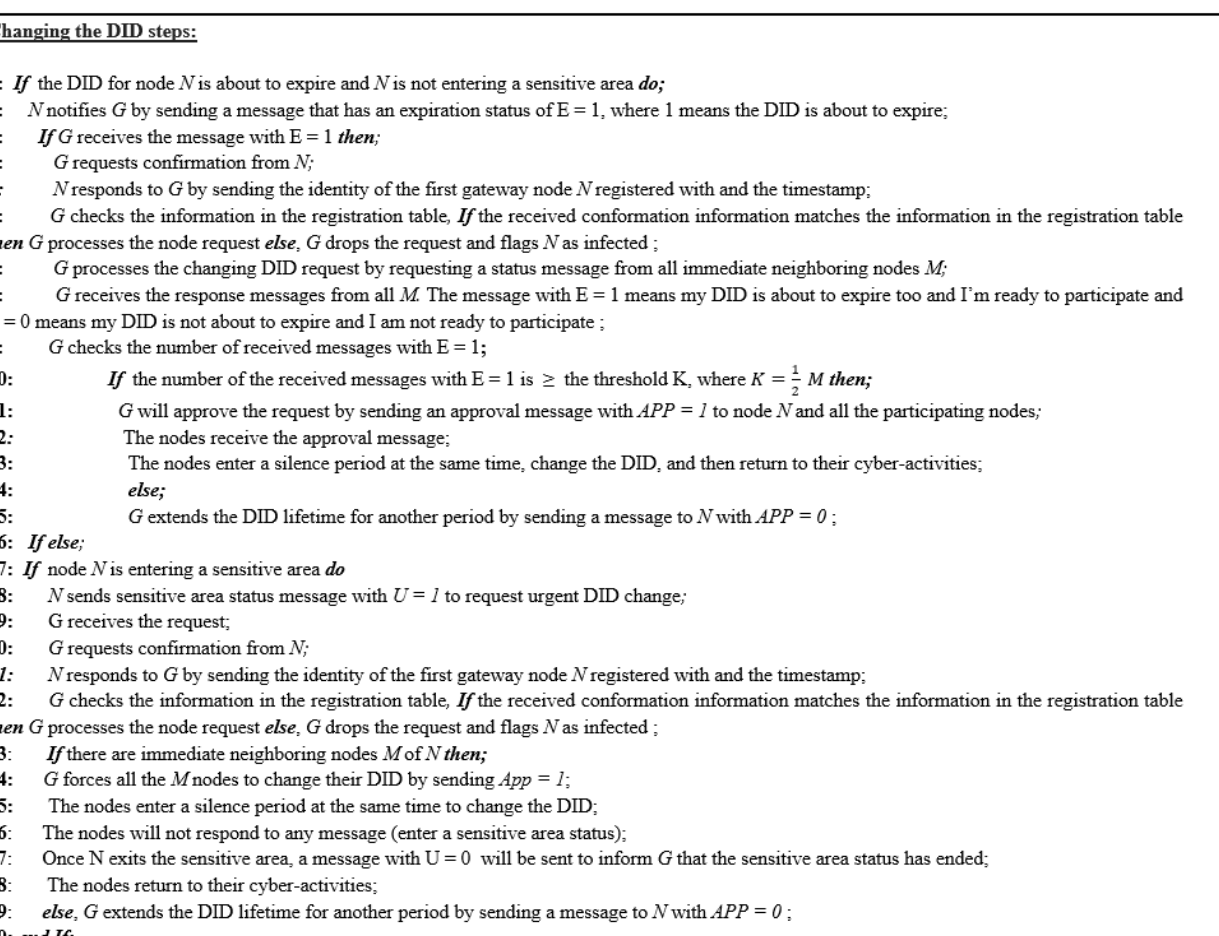
Figure 4. The algorithm for changing the